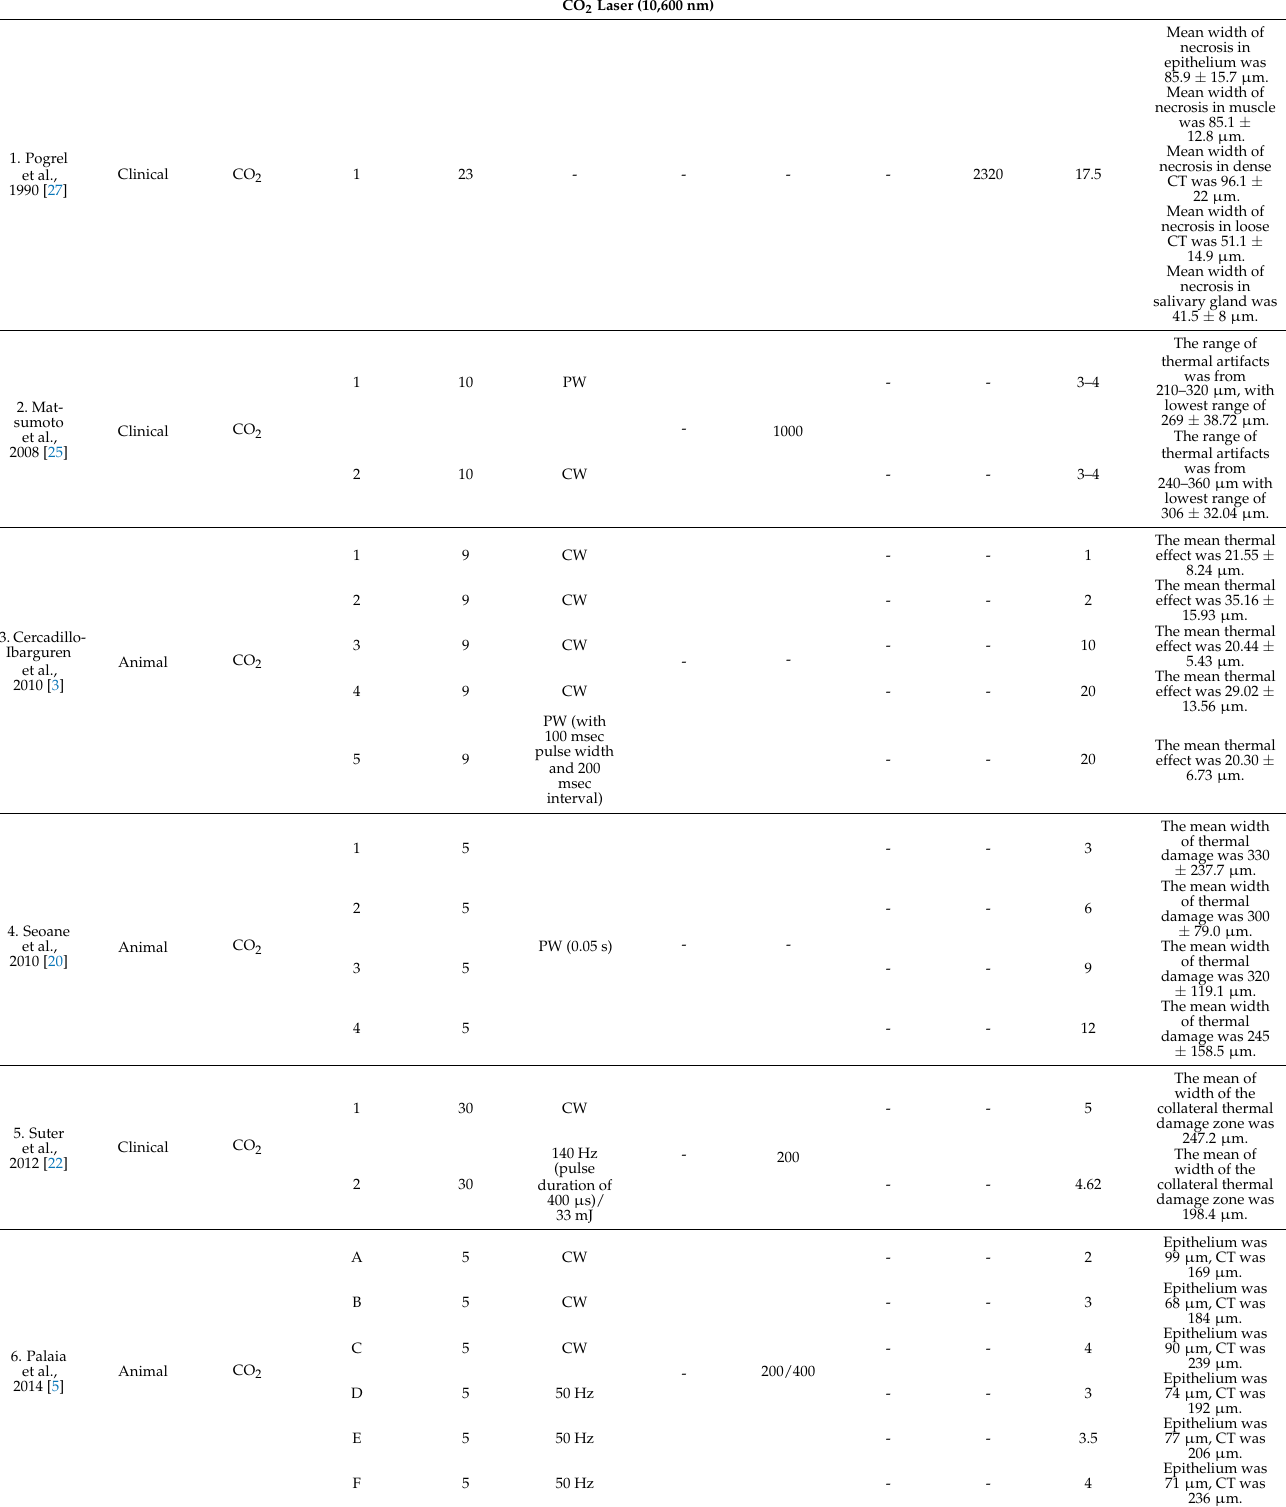
damagezonewas 198.4 µ